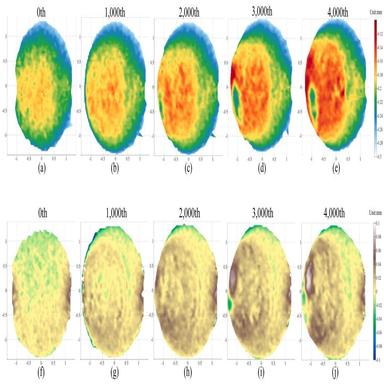
The evolution of movable and stationary electrode surface height. (a) Movable electrode at the 0th. (b) Movable electrode at the 1,000th. (c) Movable electrode at the 2,000th. (d) Movable electrode at the 3,000th. (e) Movable electrode at the 4,000th. (f) Stationary electrode at the 0th. (g) Stationary electrode at the 1,000th. (h) Stationary electrode at the 2,000th. (i) Stationary electrode at the 3,000th. (j) Stationary electrode at the 4,000th.